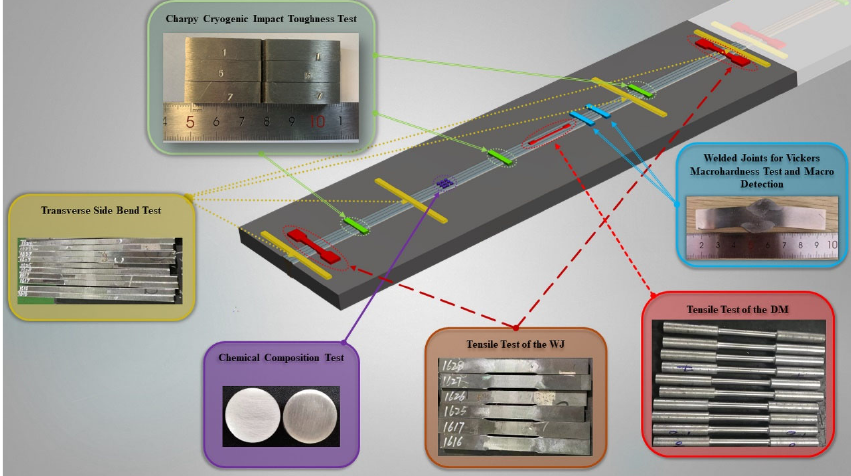
Figure 3. Schematic diagram of experimental sample (WJ: welded joint, DM: deposited metal).